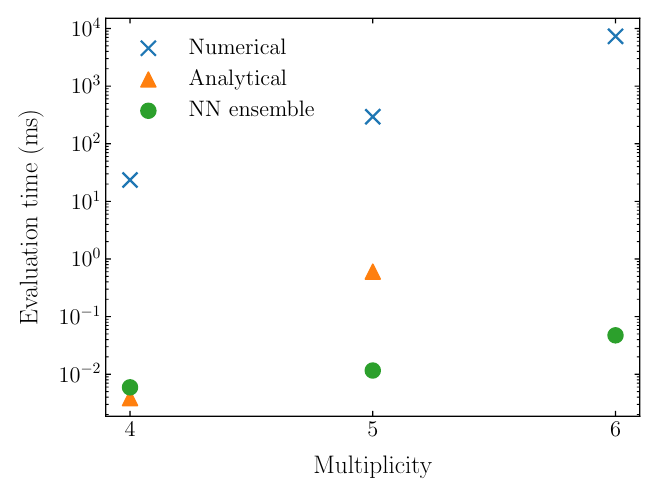
Figure 1. Matrix element typical CPU evaluation times for available methods — including NJet nu- merical evaluations, NJet analytical evaluations, and inference on a NN ensemble as described in section 3 — against the number of legs. These calls are single-threaded as parallelisation is applied at the level of events in simulations. An analytic expression for 2 → 4 is not available. The NN is comparable to the analytic call at 2 → 2 , 50 times faster at 2 → 3 , then 10 5 times faster than the 2 → 4 numeric